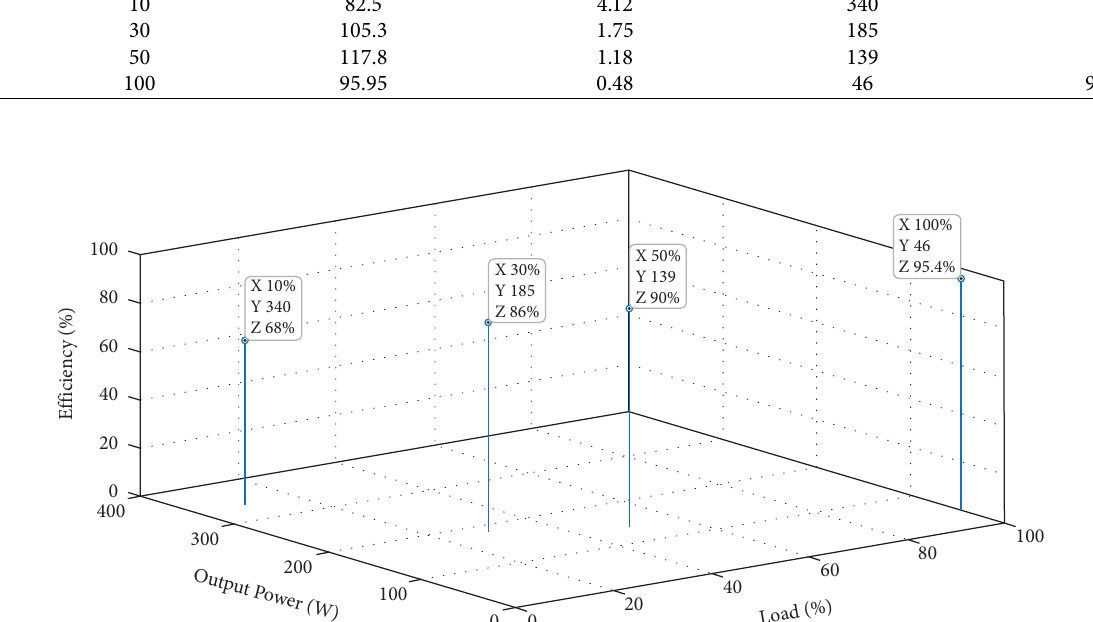
Figure 24: Performance of the proposed converter under light load